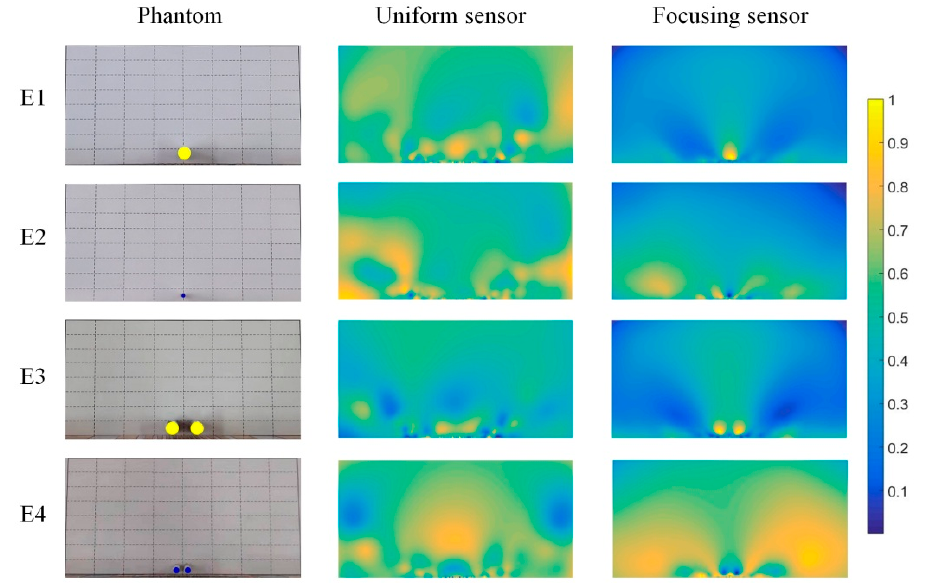
Figure 17. Experimental results from proposed focusing sensor and uniform sensor with Tikhonov